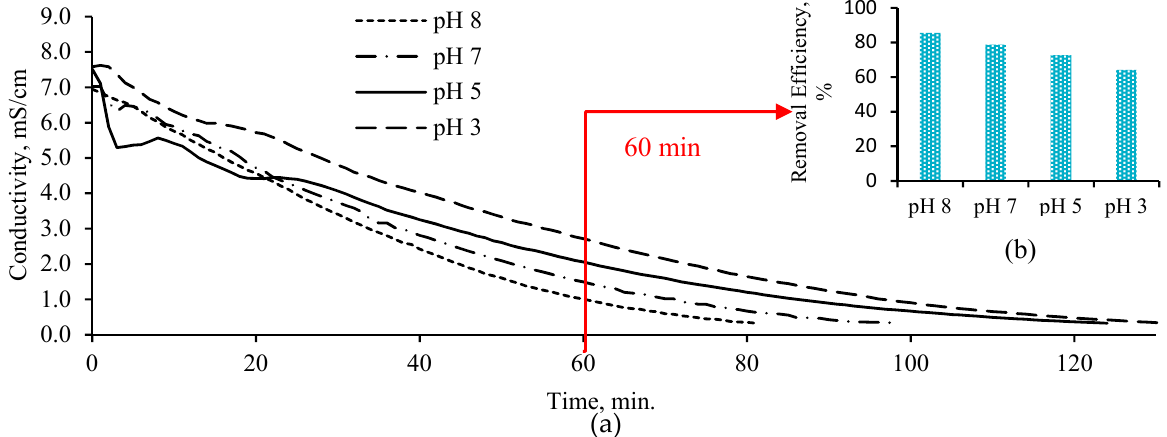
Figure 5. Conductivity values for BPMED effluent at various initial pH values ( a ) and conductivity removal efficiency at 60 min working period ( b ).